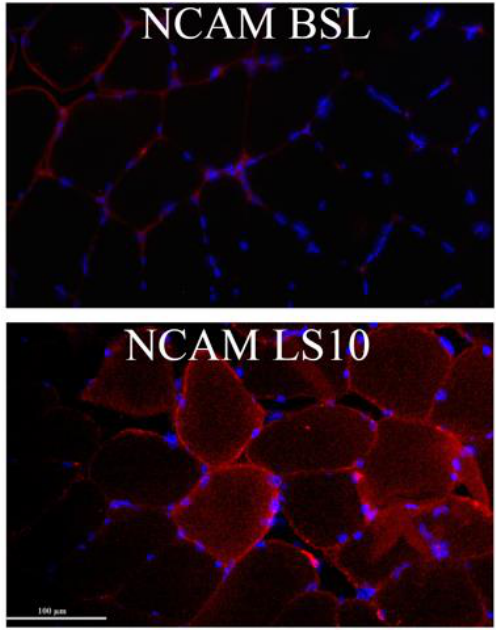
Figure 5. Representative immunohistochemistry images obtained at BSL and 10 days after limb suspension show NCAM-positive myofibers. Zeiss microscope connected to a Leica DC 300F camera, 20×.